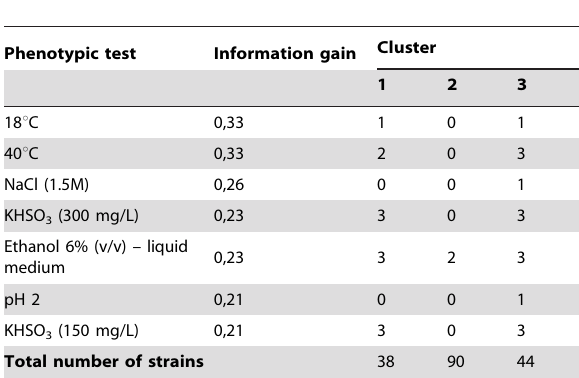
Table 2. Phenotypic tests mostly contributing for the division of strains into three clusters, in terms of information gain, obtained with k -means clustering